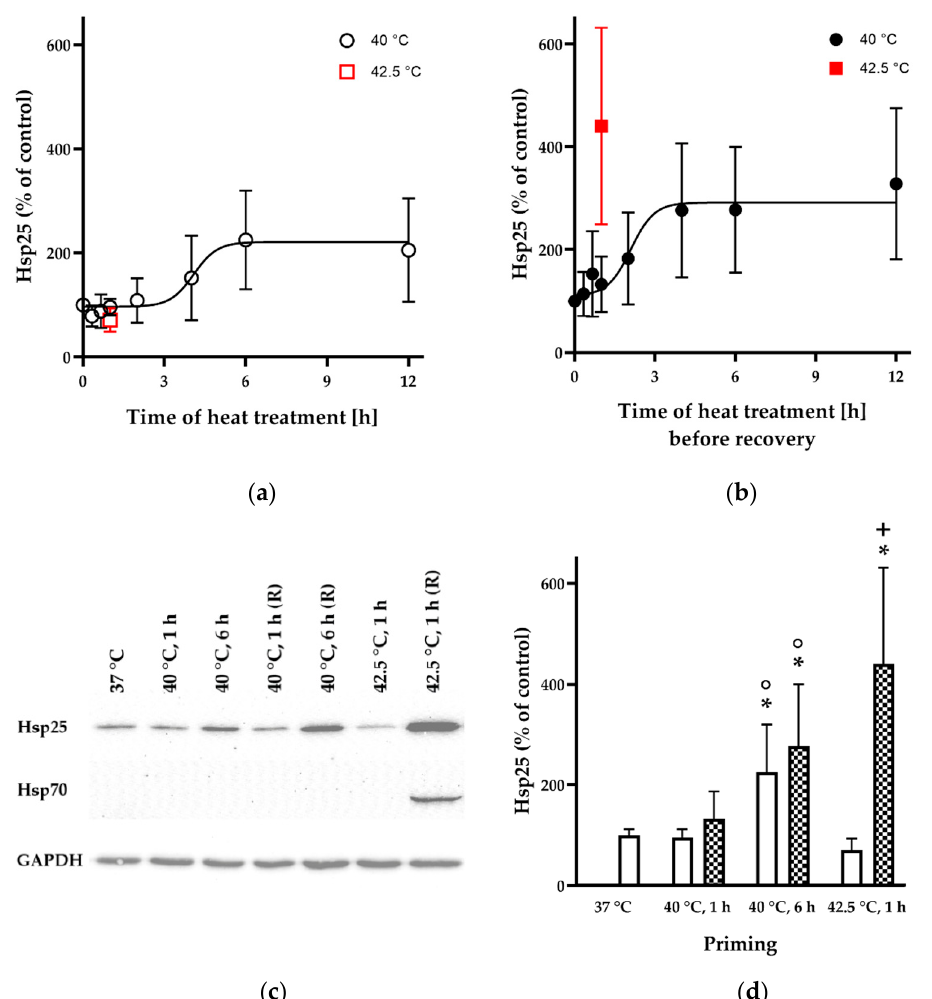
Figure 1. The effect of heat dosage on Hsp induction measured by Western blotting. ( a , b ) Time- dependent induction of Hsp25 upon mild heat treatment of CHO cells. Samples (40 °C and 42.5 °C denoted by black circles and red squares, respectively) were collected ( a ) right after (empty marks) HS or ( b ) following a 6 h recovery at 37 °C (solid marks). ( c ) Blot images of Hsp25, Hsp70 and GAPDH protein levels following a heat priming at 40 °C for 1 h or 6 h and 42.5 °C for 1 h without or with 6 h recovery (R) at 37 °C. ( d ) Relative quantification for Hsp25 induction in bar chart, in which recovery is indicated by checkerboard pattern. All data represent the means ± SD; n ≥ 5, p < 0.05 was considered statistically significant. Paired t -test was used for statistical comparisons, in which *, ° and + denote significant difference compared to 37 °C; 40 °C, 1 h with recovery; or 40 °C, 6 h with recovery, respectively. See experimental setup and blot images in Supplementary Figures S1 and S2.